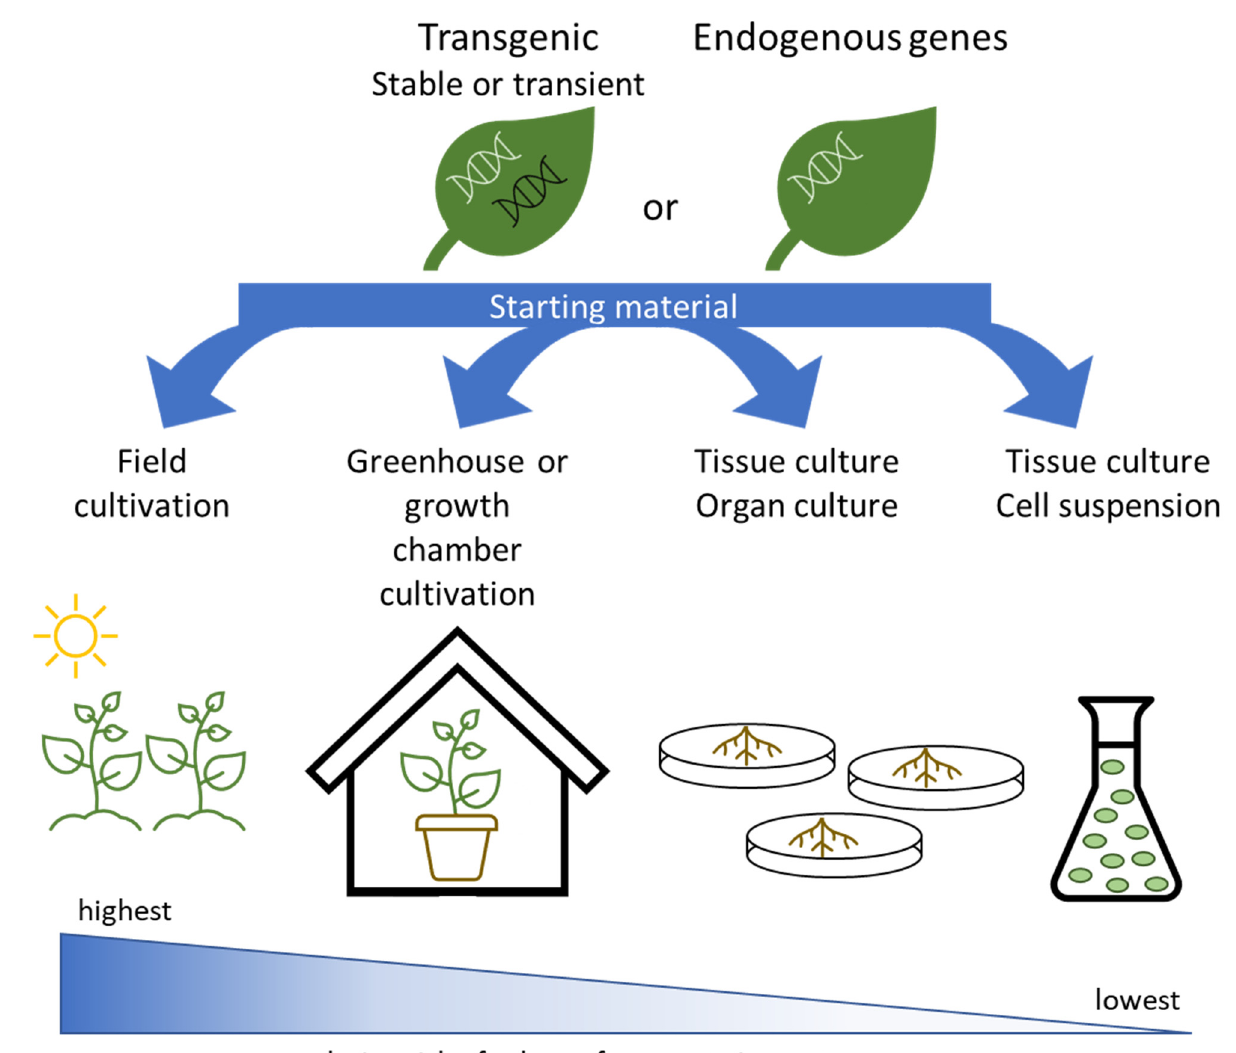
Figure 2. Options for production of molecular farming products.